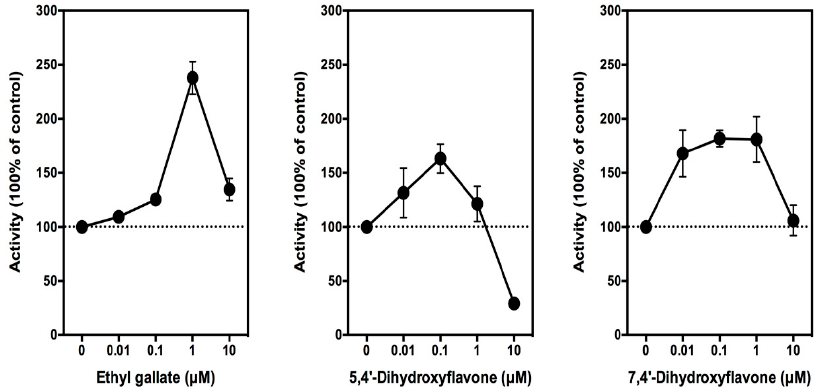
Figure 2. Effect of ethyl gallate, 5,4 ′ -dihydroxyflavone, and 7,4 ′ -dihydroxyflavone on prostaglandin E 2 (PGE 2 ) release from lipopolysaccharide (LPS)-pretreated RAW264.7 cells. Cells were pretreated with 1 µ g/mL of LPS for 2 h to induce Cyclooxygenase 2 (COX-2) expression, and then, the culture media were removed and replaced with 300 µ L of serum-free medium containing the test compound ethyl gallate for another 2 h. The following concentrations of ethyl gallate were used: 0.01, 0.1, 1, and 10 µ M. The levels of PGE 2 were measured using an enzymatic immunoassay (EIA) kit (Cayman Chemical). The PGE 2 level in the control group is 1.5 ng/mL. Each point was the mean ± standard deviation (SD) of triplet determinations.